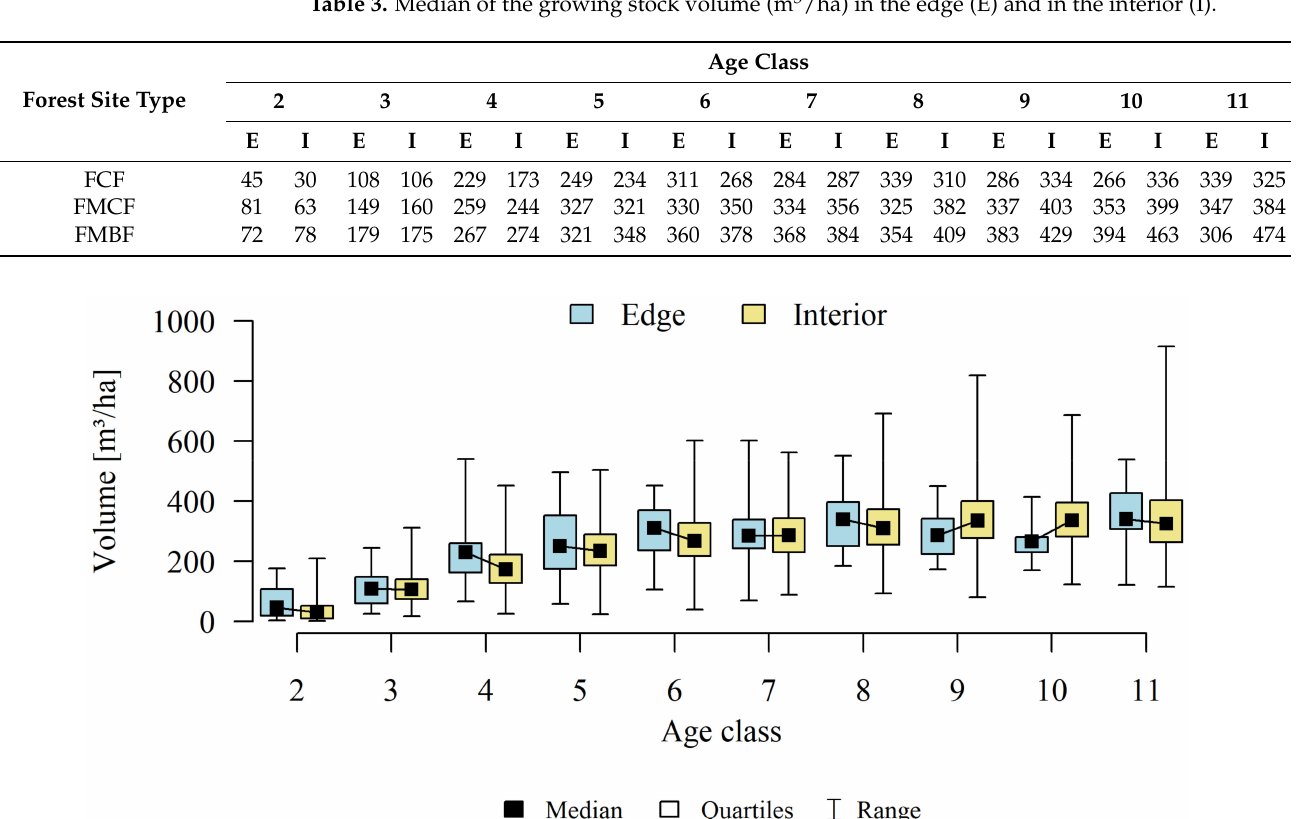
Table 3. Median of the growing stock volume (m 3 /ha) in the edge (E) and in the interior (I).